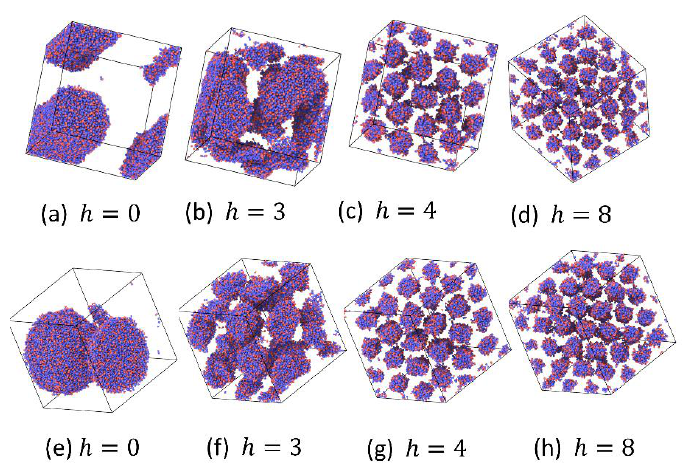
Figure 7. Snapshots of system A3B7 at different values of the reversible bond strength, ℎ . Increasing ℎ process: ( a – d ); decreasing ℎ process: ( e – h ).